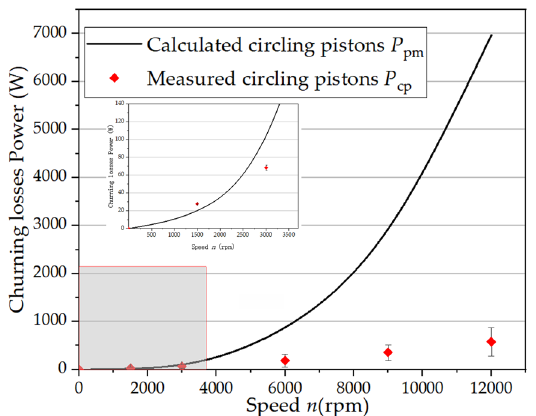
Figure 8. Churning losses: comparisons between the calculated and the experimental results.